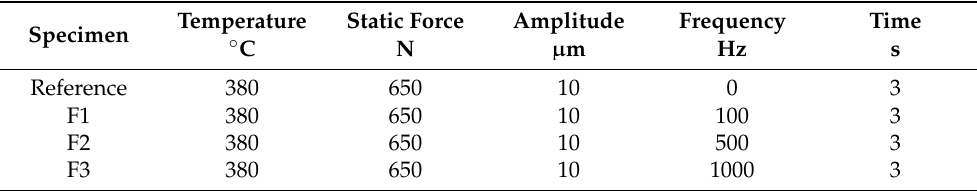
Table 1. Processing parameters used in the consolidation experiment.